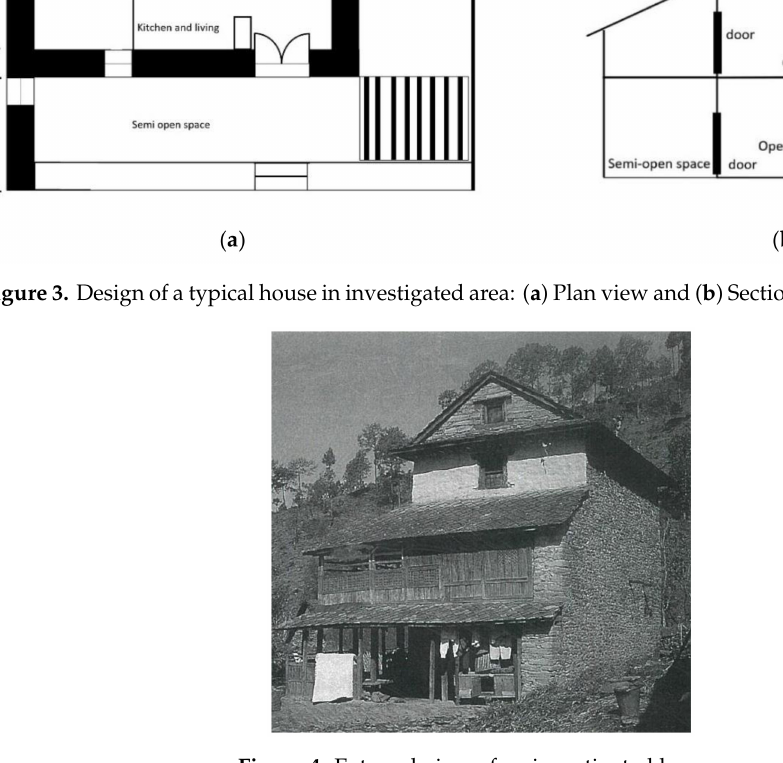
Figure 4. External view of an investigated